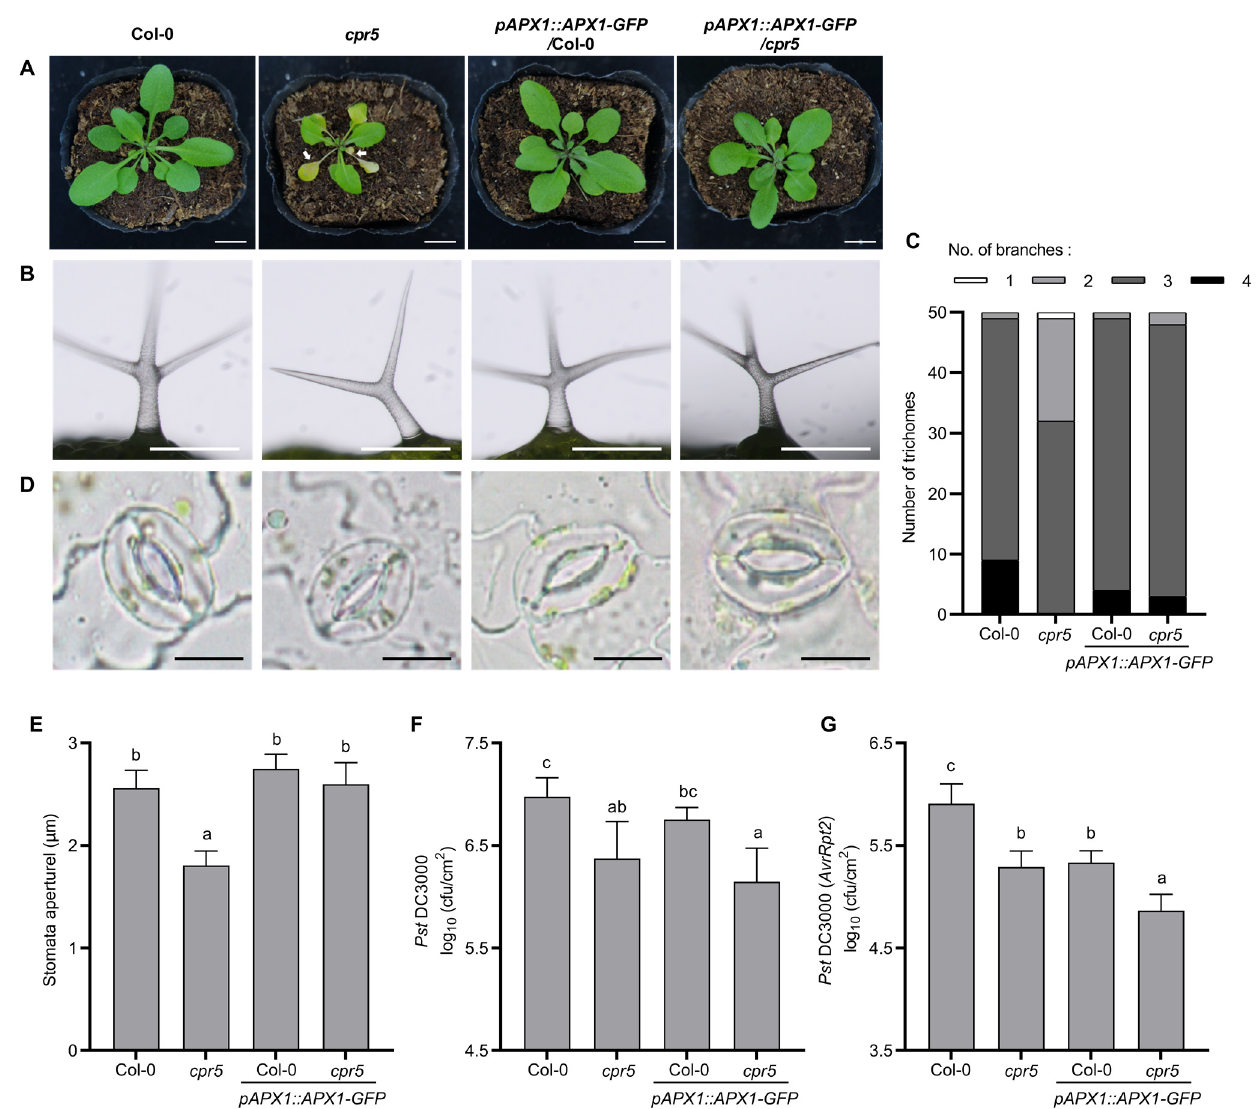
Figure 6. APX1 overexpression restores the cpr5 mutant growth phenotype. ( A ) APX1 overexpression rescued premature leaf senescence in cpr5 mutants. Images of 4-week-old plants are shown. White arrows indicate leaves in early senescence. Scale bars = 1 cm. ( B , C ) APX1 overexpression restored reduced trichome branches in cpr5 mutants. Trichomes from 4-week-old leaves were observed under light microscope. According to the number of branches, trichomes are divided into four classes. Representative images are present in ( B ), and number of trichomes in each class is shown in ( C ). Scale bars = 1 mm. Data are means ± SE (n = 50). ( D , E ) APX1 overexpression restored reduced stomatal aperture in cpr5 mutants. Stomata of 4-week-old leaves were observed under light microscope. Representative images are present in ( D ), and the value of stomatal apertures is shown in ( E ). Scale bars = 10 µ m. Data are means ± SE (n = 30). Letters above bars indicate significantly different values among groups ( p ≤ 0.05; one-way ANOVA). ( F , G ) APX1 overexpression in cpr5 did not rescue its pathogen resistance. The 4-week-old leaves were infiltrated with Pseudomonas syringae pv. tomato ( Pst ) DC3000 ( F ) and Pst DC3000 ( AvrRpt2 ) ( F ), and bacterial colonies were then enumerated 3 and 2 days post-inoculation, respectively. Data are means ± SD (n = 4). Letters above bars indicate significantly different values among groups ( p ≤ 0.05; one-way